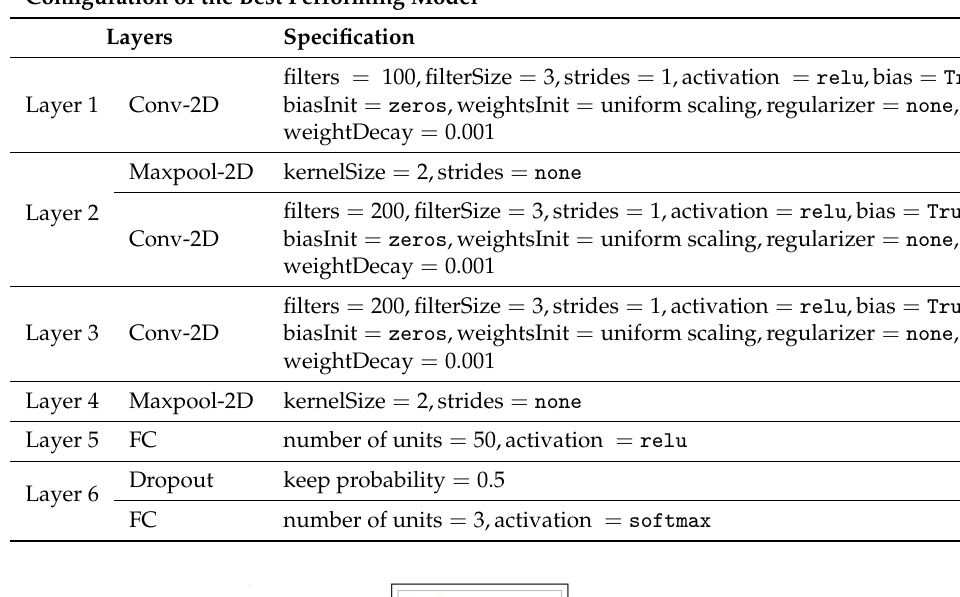
Table 1. SpectConvNet’s Layer Specification.